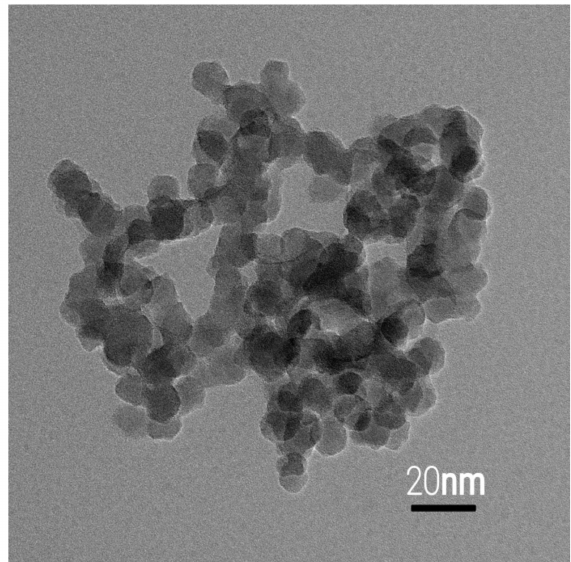
Figure 5. TEM images of Pt-doped TiO 2 .